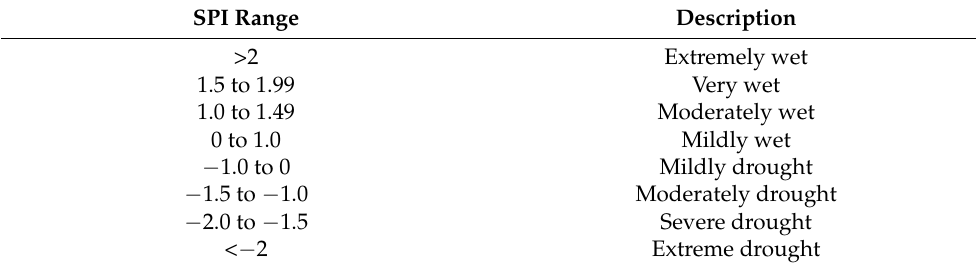
Table 3. Standard SPI Table